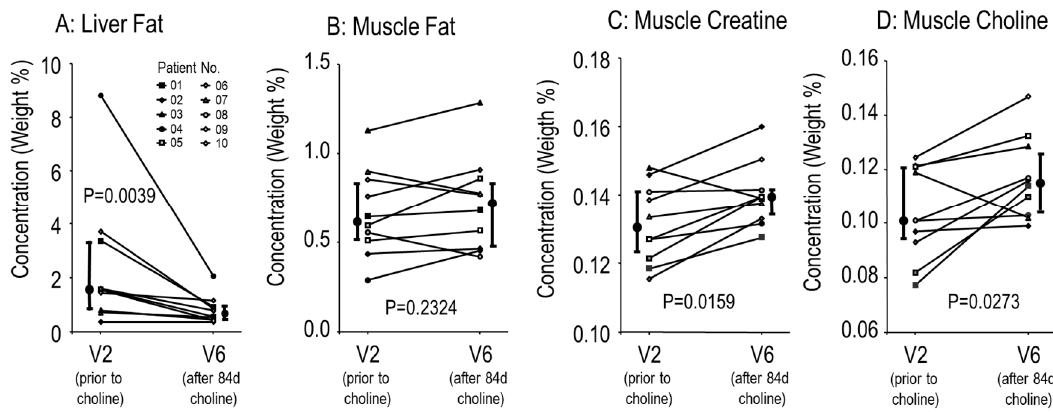
Figure 5. Effects of choline supplementation on liver and muscle tissue. Liver ( A ) and muscle fat ( B ), and muscle creatine ( C ) and choline ( D ) were investigated with magnetic resonance spectroscopy as shown in Materials and Methods. Small symbols and thin lines indicate individual values of patients, whereas large symbols and thick bars indicate medians and interquartile ranges. p , significance level.